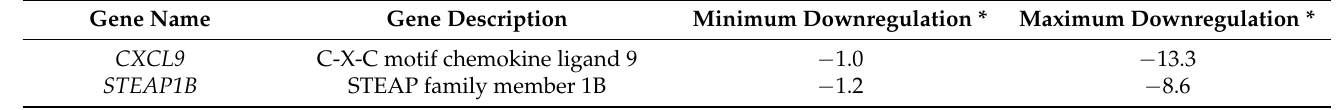
Table 3. Gene downregulated after exposure to 1,25D in the cells from all